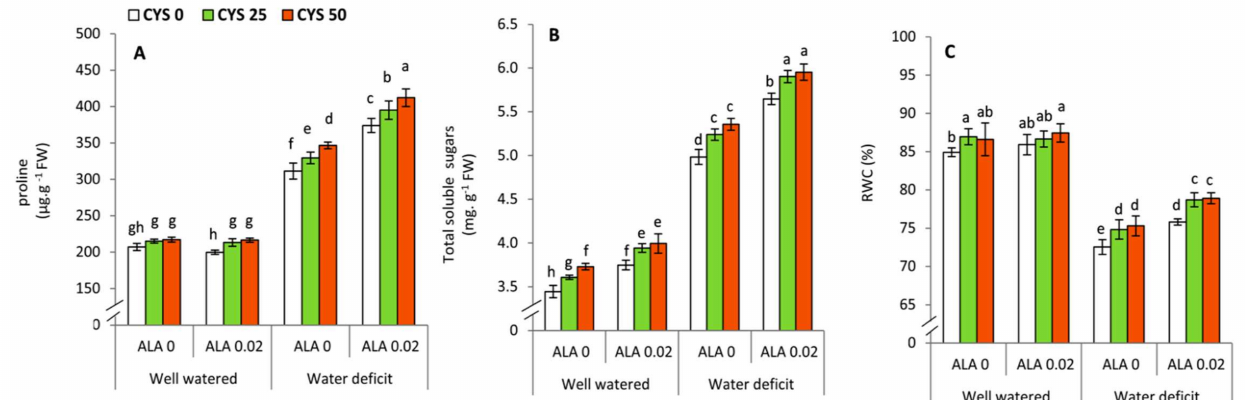
Figure 5. Effect of irrigation level, seed soaking by α -lipoic acid (ALA; 0 and 0.02 mM) and foliar application by cysteine (Cys; 0, 25 and 50 ppm) on the concentration of osmolytes and leaf relative water content (RWC) of wheat plants. ( A ) Proline, ( B ) Total soluble sugars, ( C ) RWC. For each parameter, the mean values ± SD followed by a different letter are significantly different according to Tukey’s range test ( p ≤